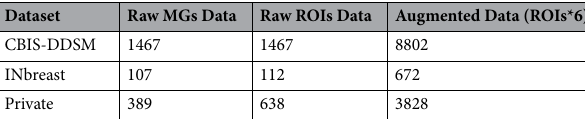
Table 1. General datasets distribution.